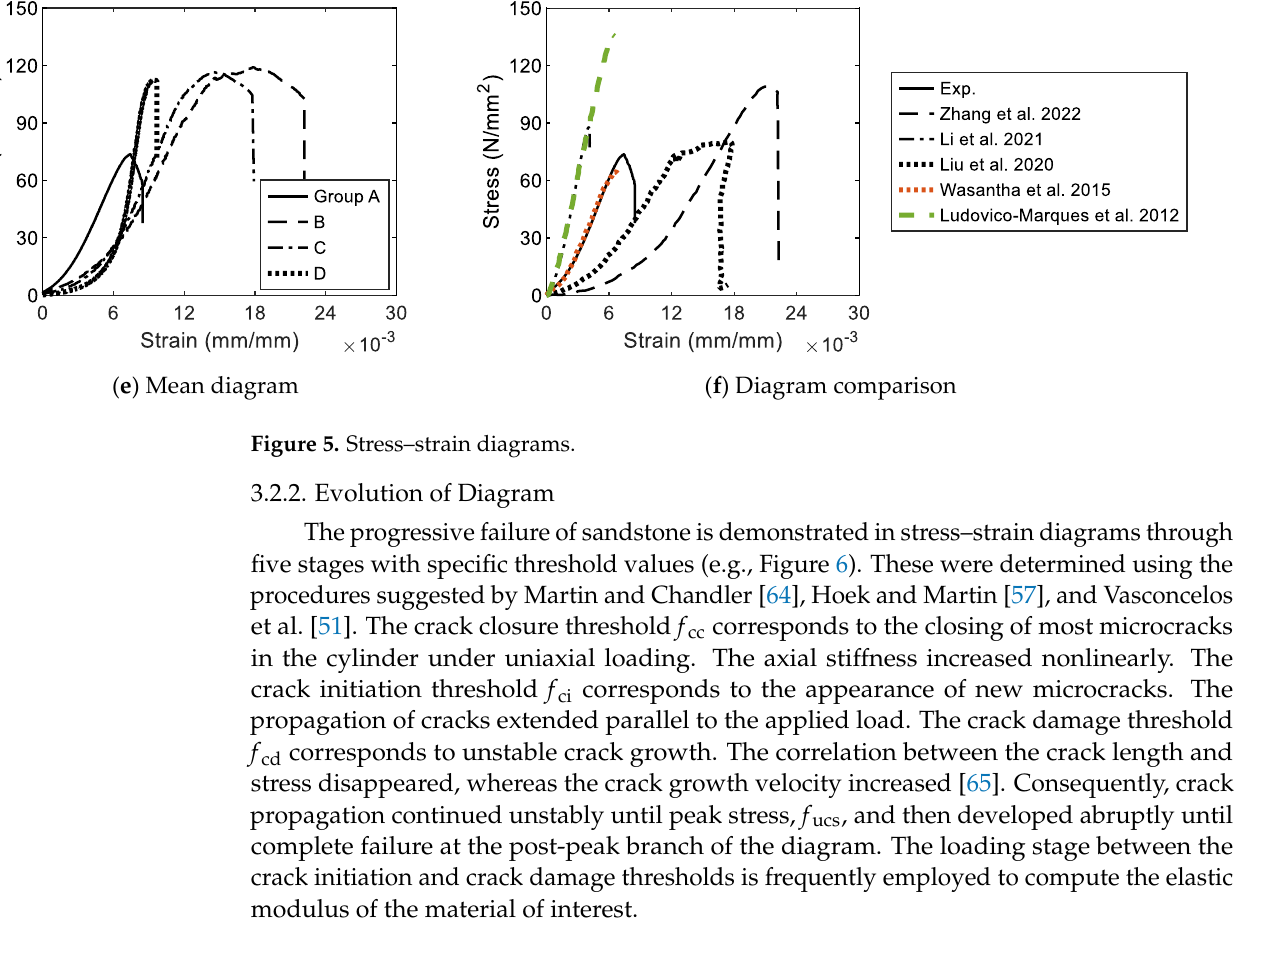
Figure 6. Progressive failure of brittle material (adapted from [28]).